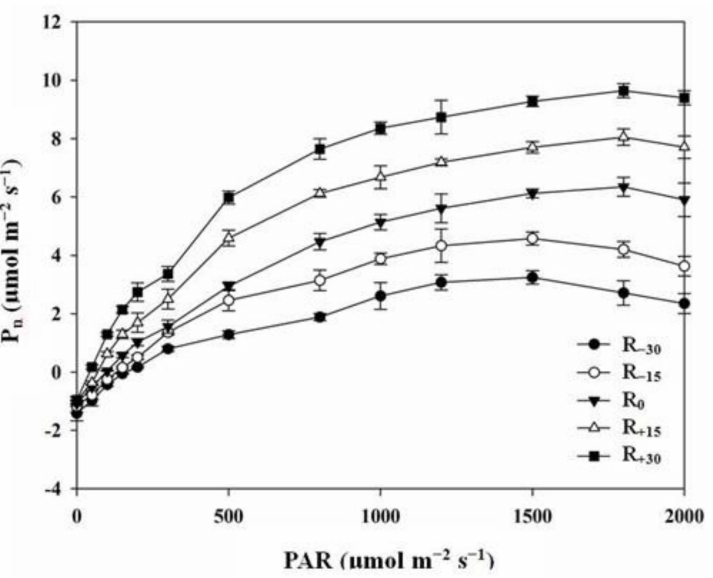
Figure 3. P n –PAR curves under rainfall change. P n , net photosynthetic rate; PAR, photosynthetic active radiation; R 0 , mean monthly rainfall from May to August during the period from 1961 to 2018; R − 30 , R 0 decreased by 30%; R − 15 , R 0 decreased by 15%; R +15 , R 0 increased by 15%; R +30 , R 0 increased by 30%.Values are shown as means ± SE (n = 3).